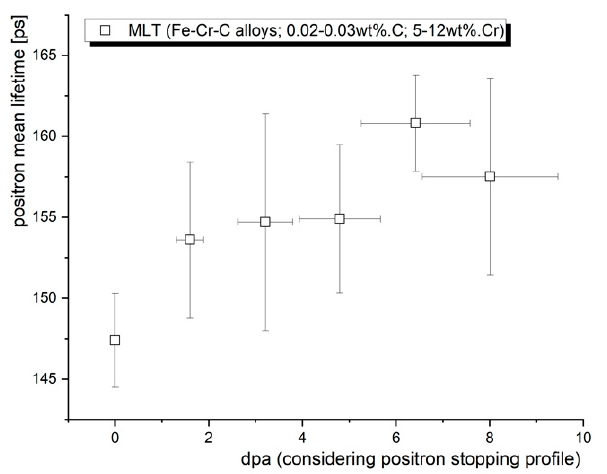
Figure 6. Average values of the positron mean lifetime for three Fe-Cr-C alloys implanted to five different fluencies.